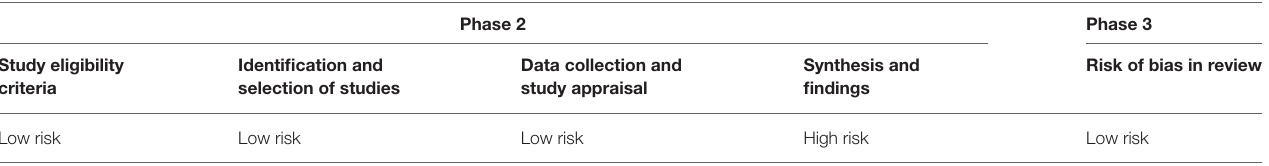
TABLE 4 | Risk of Bias in Systematic Reviews (ROBIS tool) of the